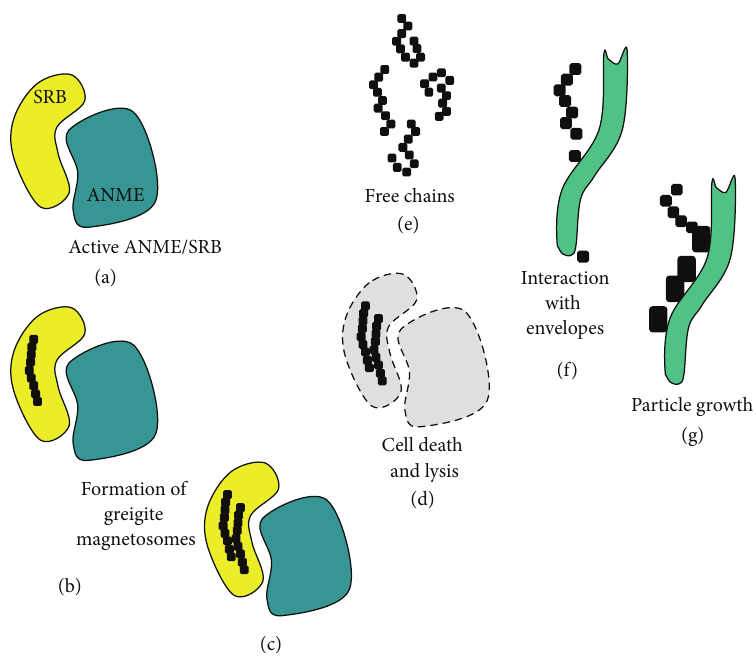
Figure 6: Turnover of magnetosome-like chains in the black layer. See Section 3 for further